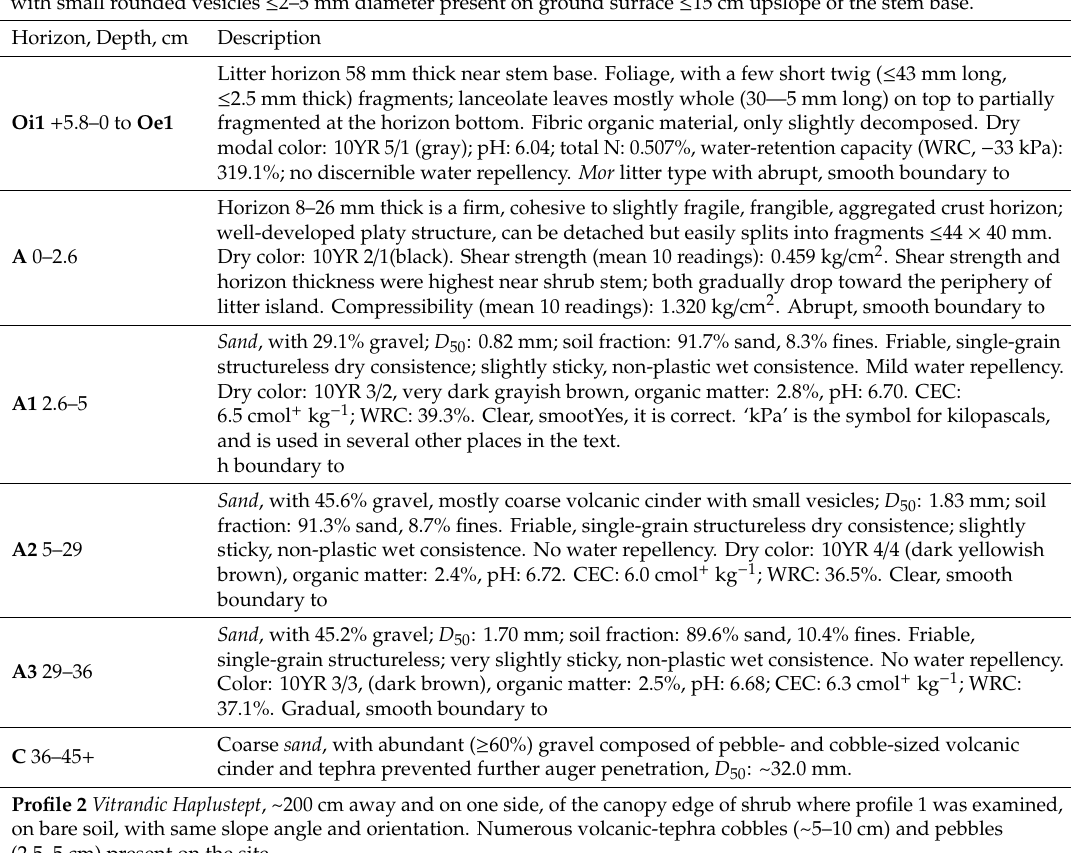
Table 4. Description of two representative soil profiles from the research site, at ~2705 m, Haleakal¯a crater. Colors are for dry soils (Munsell Soil Colors [83]); consult Soil Survey Sta ff [71] for horizon symbols and further